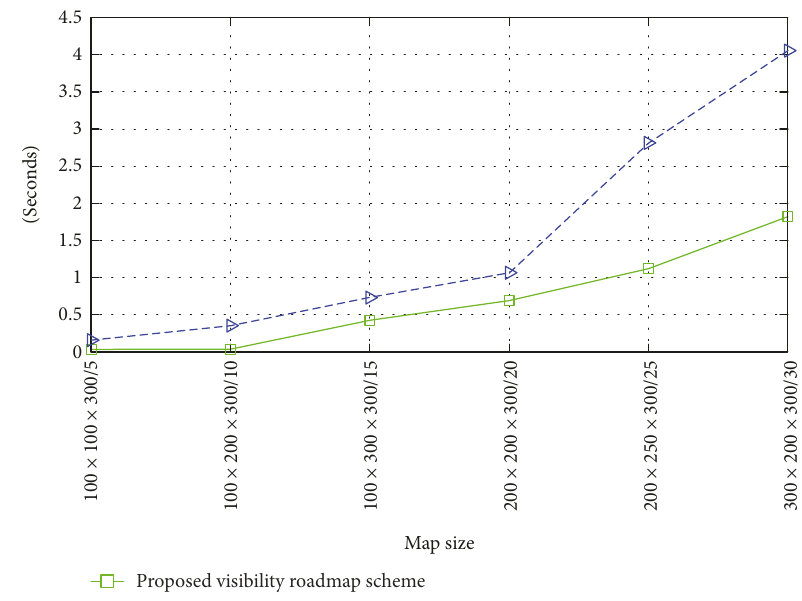
Figure 13: A comparison in terms of computing speed between two path fi nding algorithms. Table 6: Simulation results based on NYC Open Data. Dataset